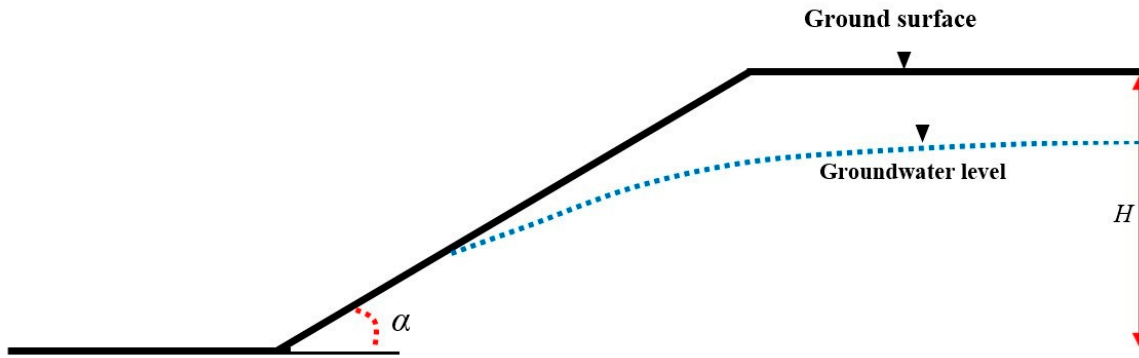
Figure 3. Schematic of the considered slopes. Table 2. Dataset considered in the present study (Sah et al. [80]).